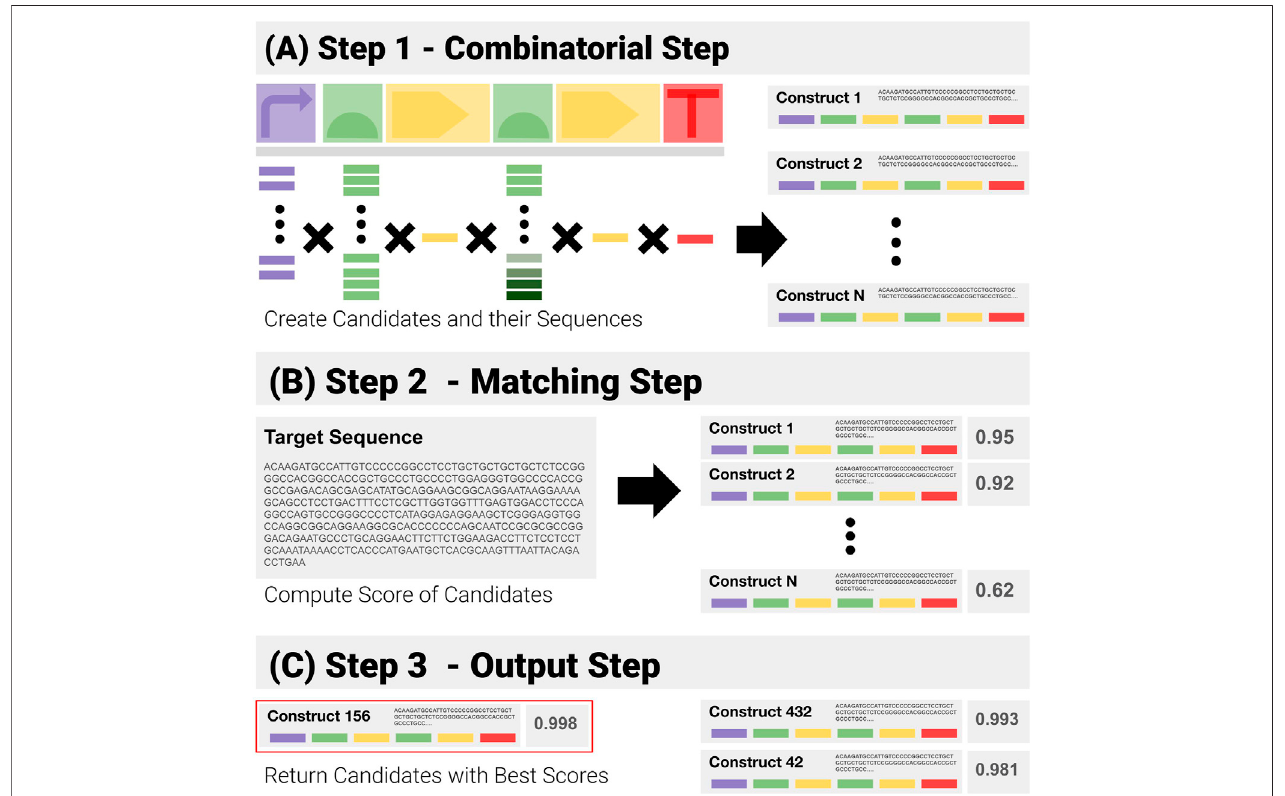
FIGURE4| VisualRepresentationoftheConstruct-MatchingAlgorithmCM_0.CM_0isasequencematchingalgorithmthatfailstoexploitmodularity.Itismadeof three steps. (A) Step 1 - CM_0 generates the sequences for all possible constructs in the search space. (B) Step 2 - These candidate sequences are matched to the input sequence — returning for each a global matching score. (C) Step 3 - Constructs with the highest scores are returned.